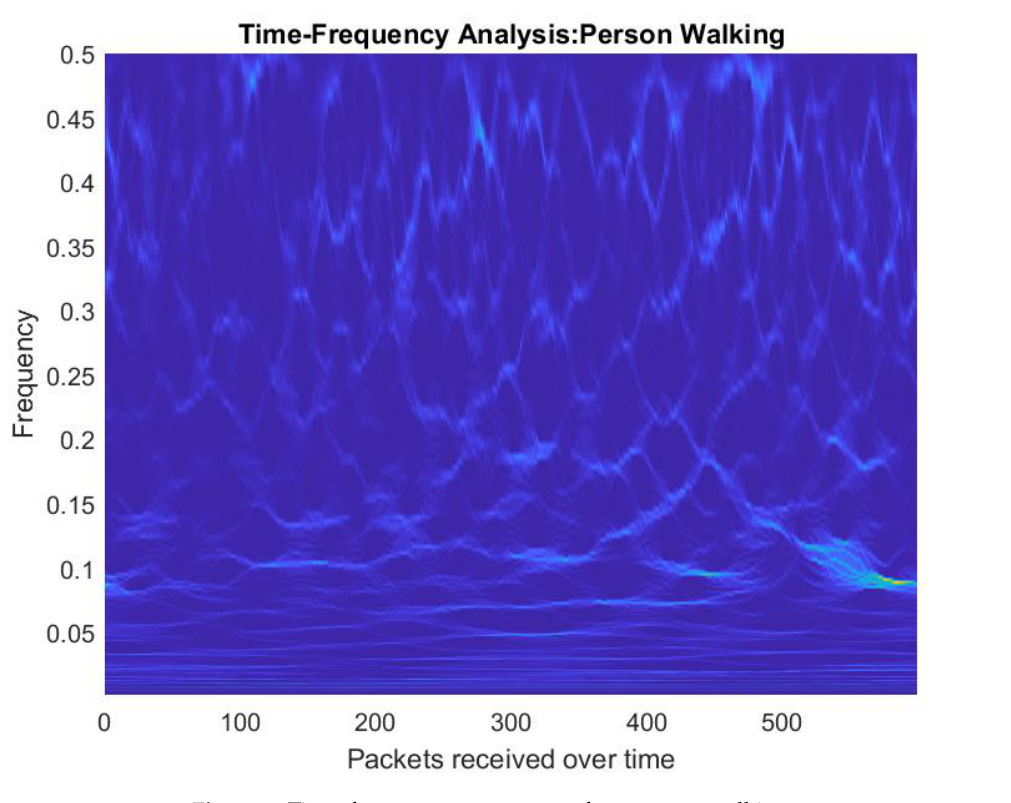
Figure 6. Time–frequency spectrogram for a person walking.